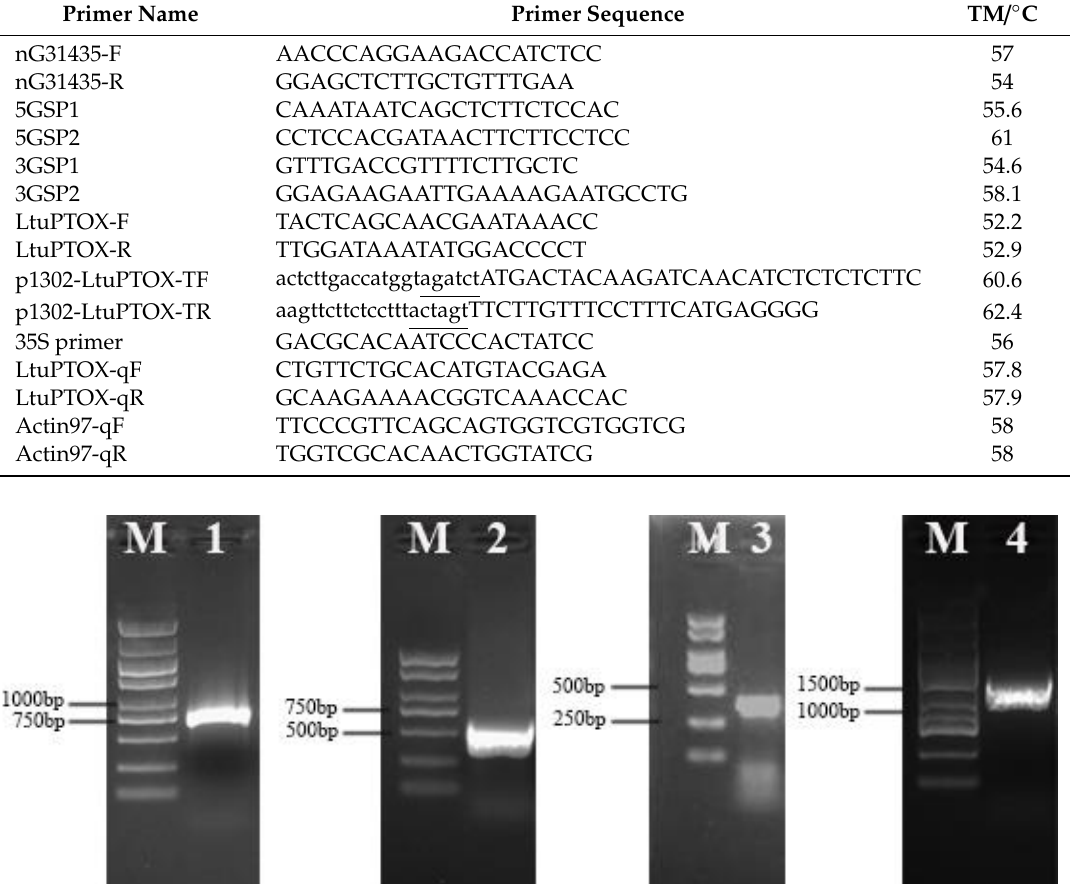
Table A1. Primer sequences used in the article.